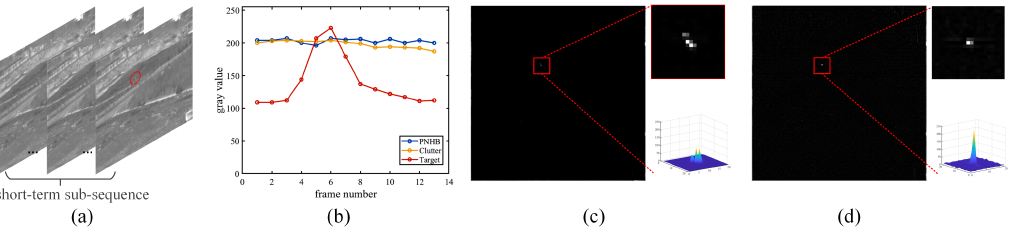
Figure 5. An example of a short-term sub-sequence. ( a ) The short-term sub-sequence containing registered images. ( b ) The grayscale curves of different areas in the local temporal dimension. ( c , d ) The detection results of the IFD method and SEA method, and a red box marks the actual target area with a close-up version and its 3D view shown on the right-top and right-bottom,